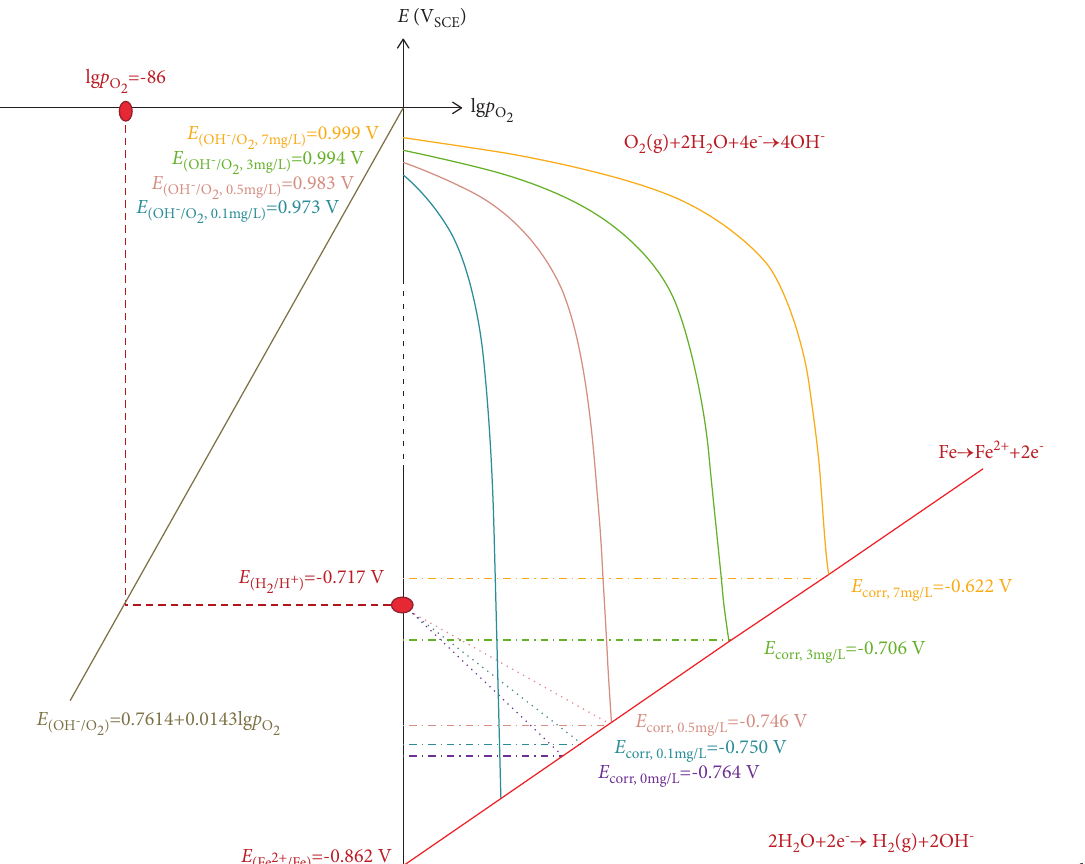
Figure 8: Evans diagram for the corrosion of X80 pipeline steel in the 3.5% NaCl solution with different dissolved oxygen concentrations (from